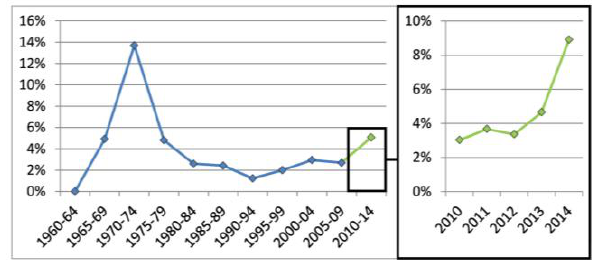
Figure 6. Use of the term „photogrammetry‟ in publications on underwater archaeology over the past 55